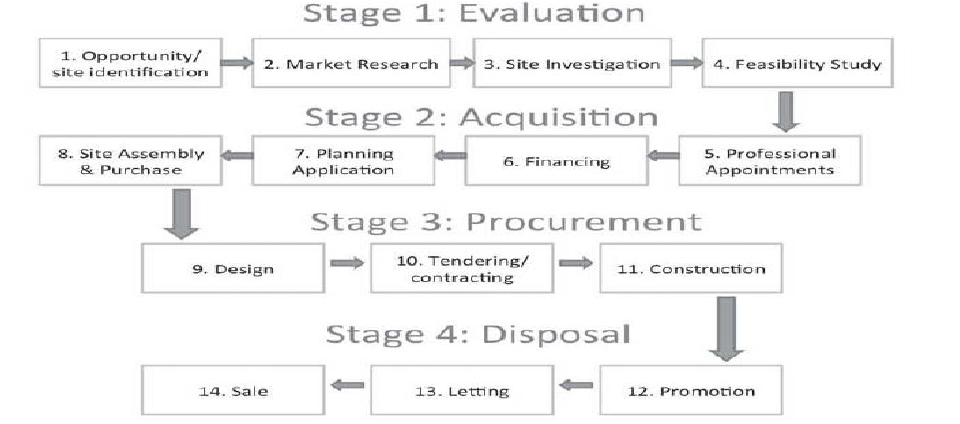
Fig. 1. 14 phases of property development (Jowsey, 2015, p.